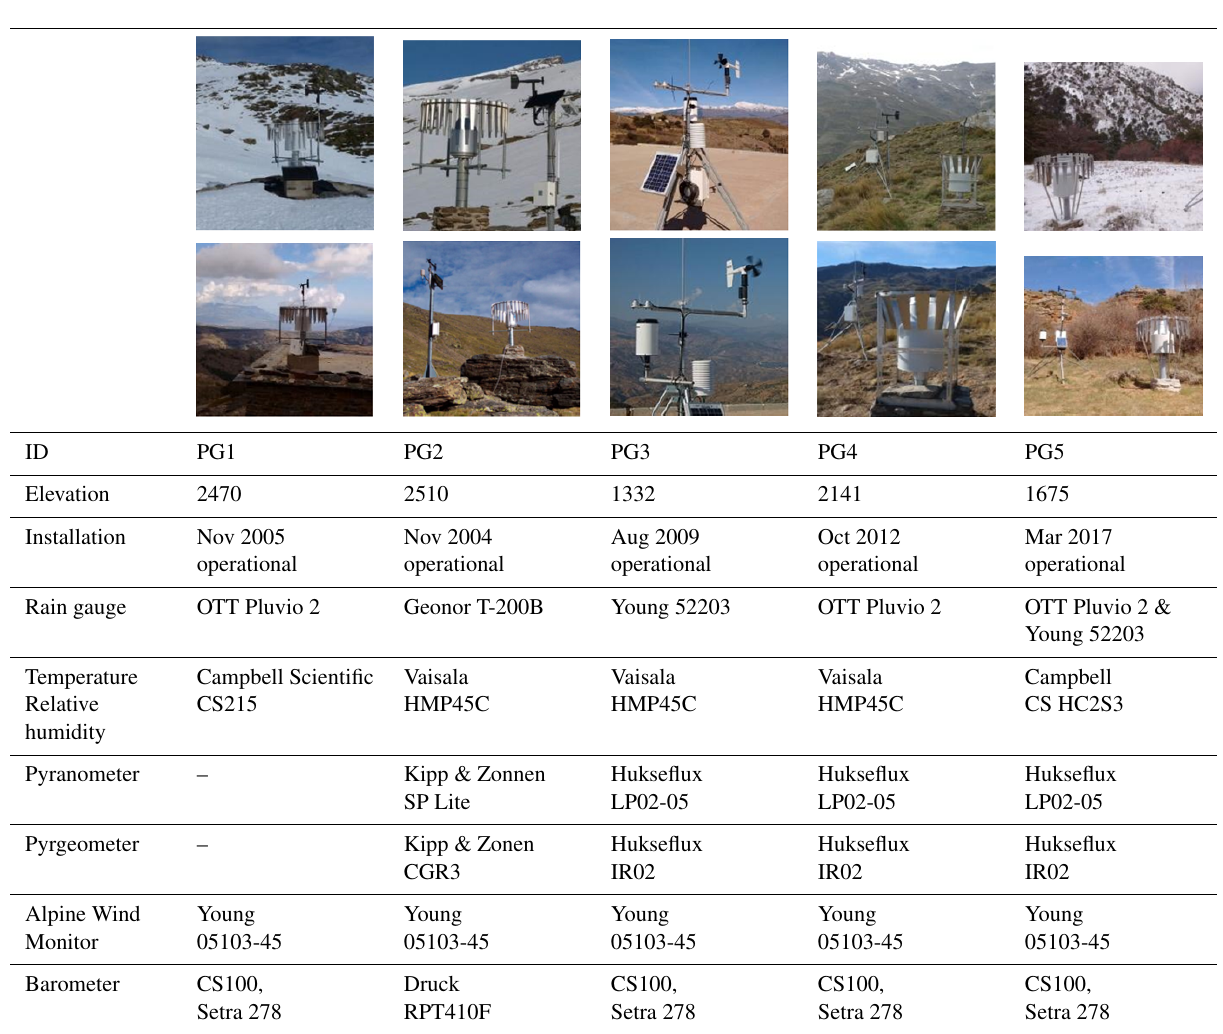
Table 1. Main characteristics of the weather stations in the Guadalfeo Network: elevation (ma.s.l.), date of installation and instruments. In situ pictures are also